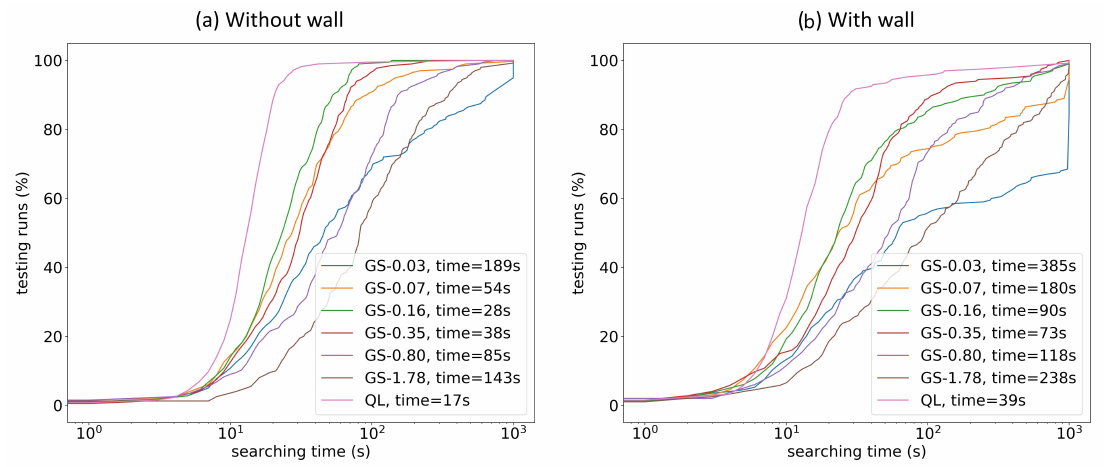
Figure A1. Parameter tuning for the gradient search method. These two plots represent the percentage of testing runs that are finished within specific searching times. Plot ( a ) shows the results from simulation area without walls, and plot ( b ) shows the results from simulation area with walls. ’GS’ stands for the gradient search method, the number after ’GS’ represents the q value. ’time’ represents the mean searching time for that specific setting. ’QL’ stands for the Q-learning method. Without walls, the best q is 0.16; with walls, the best q is